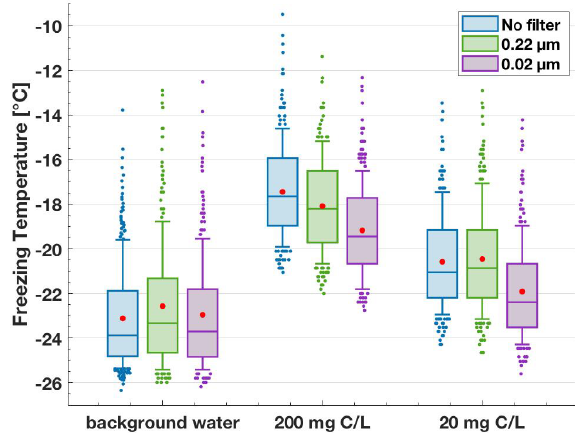
Figure 5. Freezing temperature boxplots for the size filtration se- ries. Aqueous lignin solutions of 200 and 20mgCL − 1 concentra- tion were filtered through 0.22 and 0.02µm sterile syringe filters. The filtration step reduced the T 50 values; however, the measured IN activity remained above the background for all